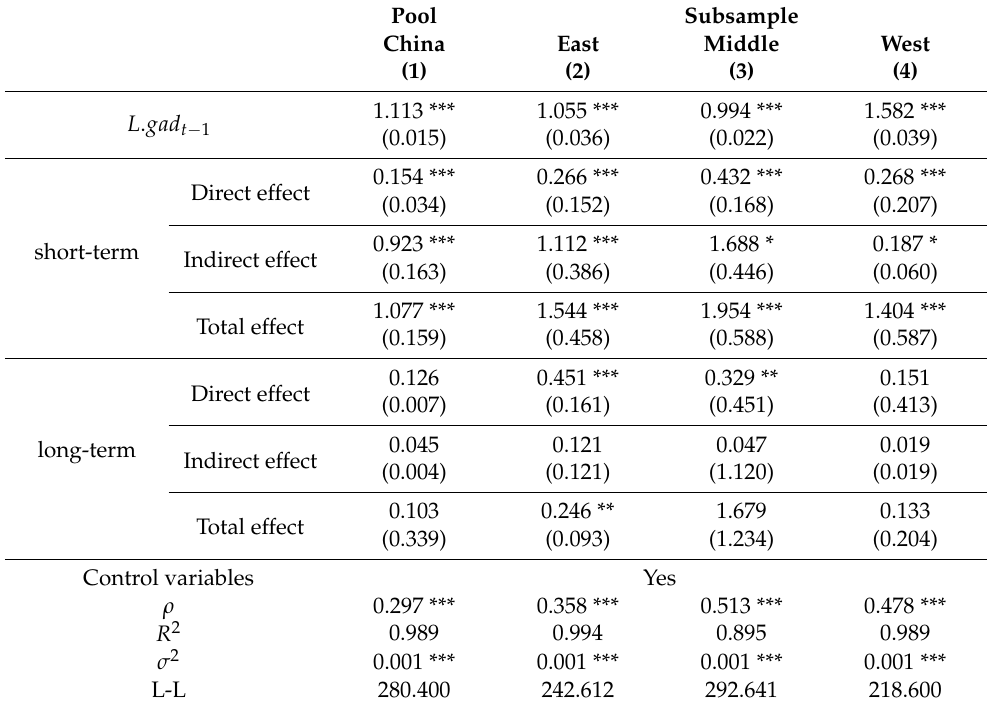
Table 7. Robustness test results for the dynamic spatial Durbin model.